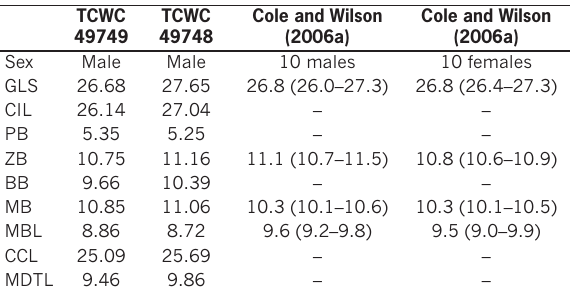
Table 2. Cranial measurements (in mm) of the two individu- als of L. yerbabuenae recorded in 1991 by R. D. Bradley et al. in the department of Valle, southern Honduras (Garner 2016b, 2016c). The records of Cole and Wilson (2006a) are from south- ern Arizona and Mexico (means before parentheses and ranges are included on